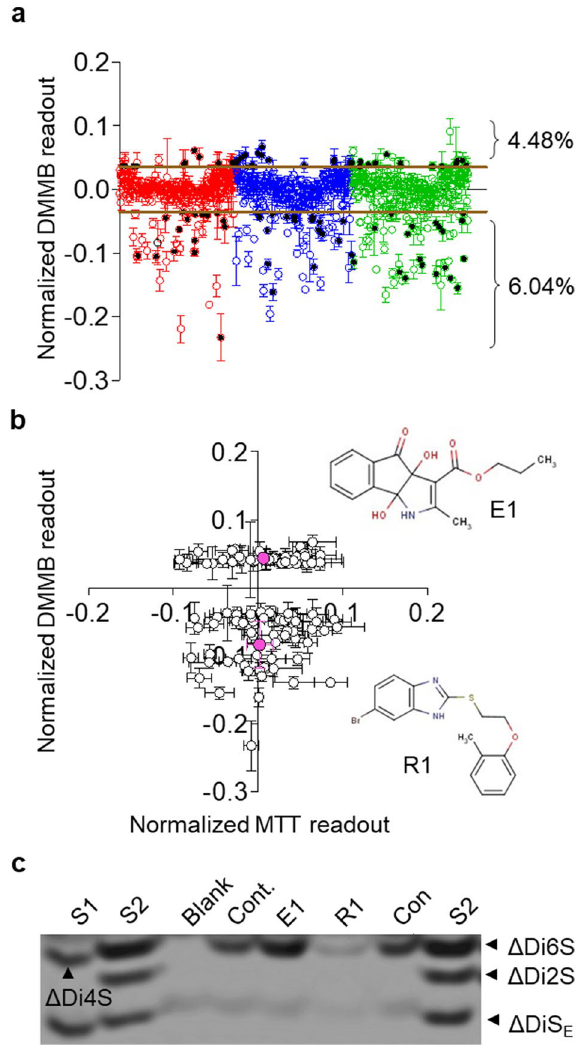
Figure 4. Performance of 960 compounds in the HTS DMMB assay. ( a ) Scatter plot of DMMB assay readouts from 960 compounds. The median of each plate was used for subtraction normalization. The primary screen activities were identified with readings greater or lower than the plate median + 3 SD. Each batch contained 320 compounds and was performed in triplicate. Hits were highlighted by black dots. ( b ) Array of hits compounds in MTT assay. Insert: chemical structures of an enhancer (E1, upper) and a repressor (R1, lower) compound. ( c ) E1 and R1 were tested in primary chondrocytes cultured in a 3D alginate culture system. Analysis of compositional disaccharides by fluorophore-assisted carbohydrate electrophoresis (20% acrylamide) indicated regulation of chondroitin sulfate GAG expression. Standards are shown in the margins (arrow). S1: ΔDi4S, ΔDiS E ; S2: ΔDi6S, ΔDi2S, ΔDiS E